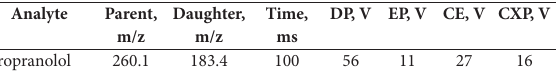
Table 2. Multiple reaction monitoring (MRM) parameters of atorvastatin.